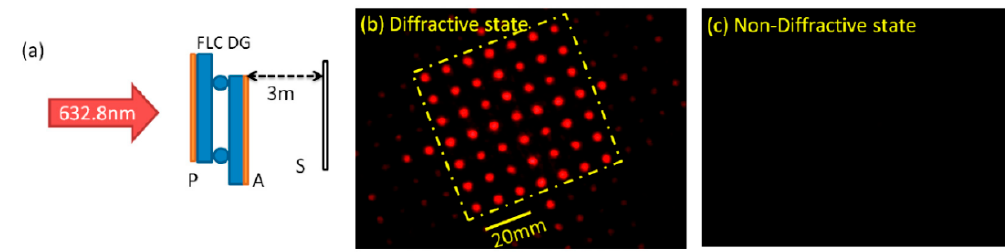
Figure 12. ( a ) Optical setup for demonstration of the diffraction performance in the DG; ( b ) observation of the diffractive state; ( c ) non-diffractive state [67].